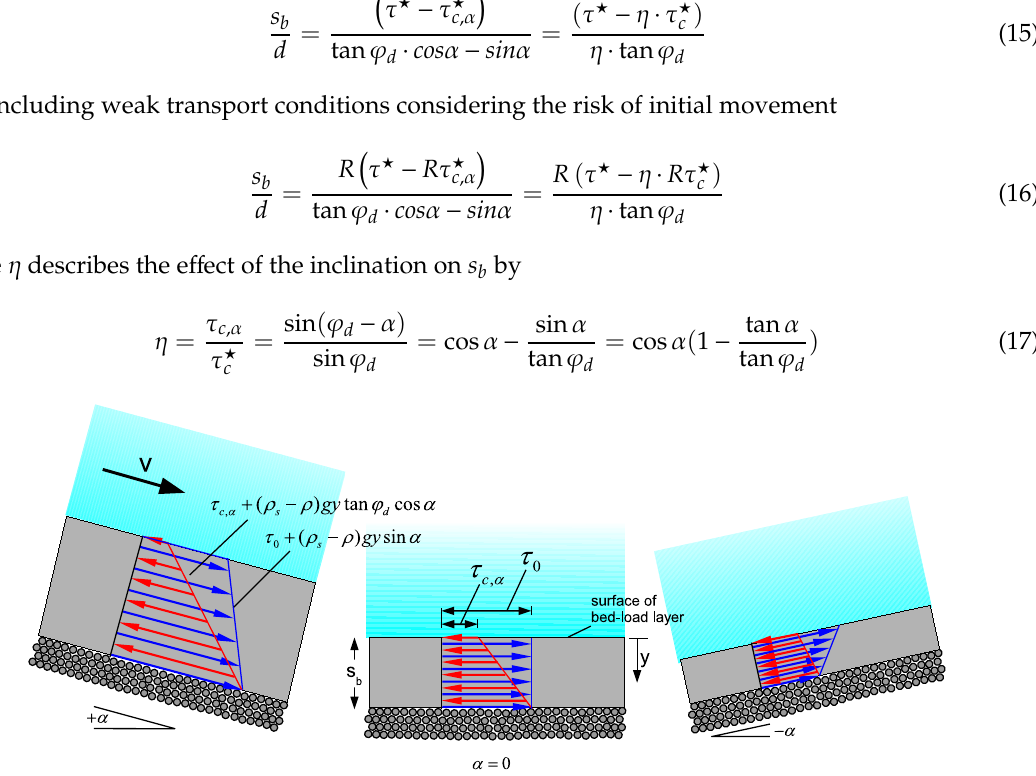
Figure 2. Bed-load layer thickness, balance of stresses